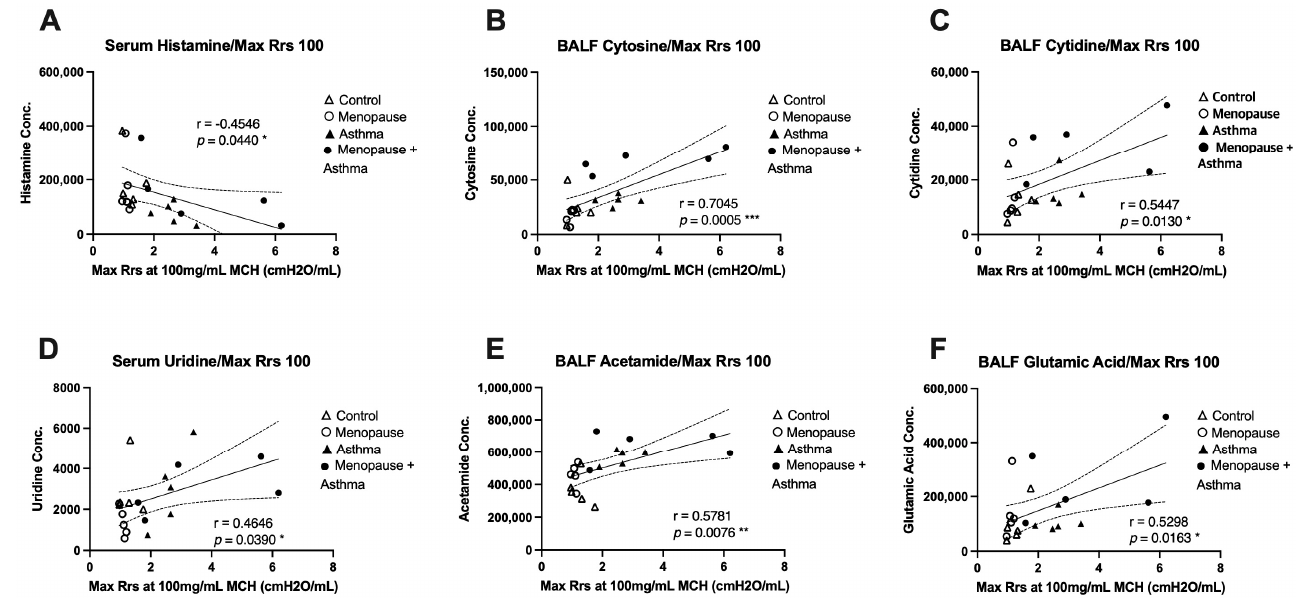
Figure 5. Correlation plots of metabolites with total airway resistance (Rrs). Airway resistance from the 100mg/mL methacholine dose was assessed using the Flexivent system and association analysis performed for the most signi fi cantly di ff erent metabolites detected. ( A ) Serum histamine concentration with a negative correlation to Rrs, * p = 0.044. ( B ) BALF cytosine concentration with a positive correlation to Rrs, *** p = 0.0005. ( C ) BALF cytidine with a positive correlation to Rrs, * p = 0.013. ( D ) Serum uridine with a positive correlation with Rrs, * p = 0.039. ( E ) BALF acetamide with a positive correlation to Rrs, ** p = 0.0076. ( F ) BALF glutamic acid with a positive correlation to Rrs, * p = 0.0163. All statistical signi fi cance was achieved using Pearson’s correlation coe ffi cient.